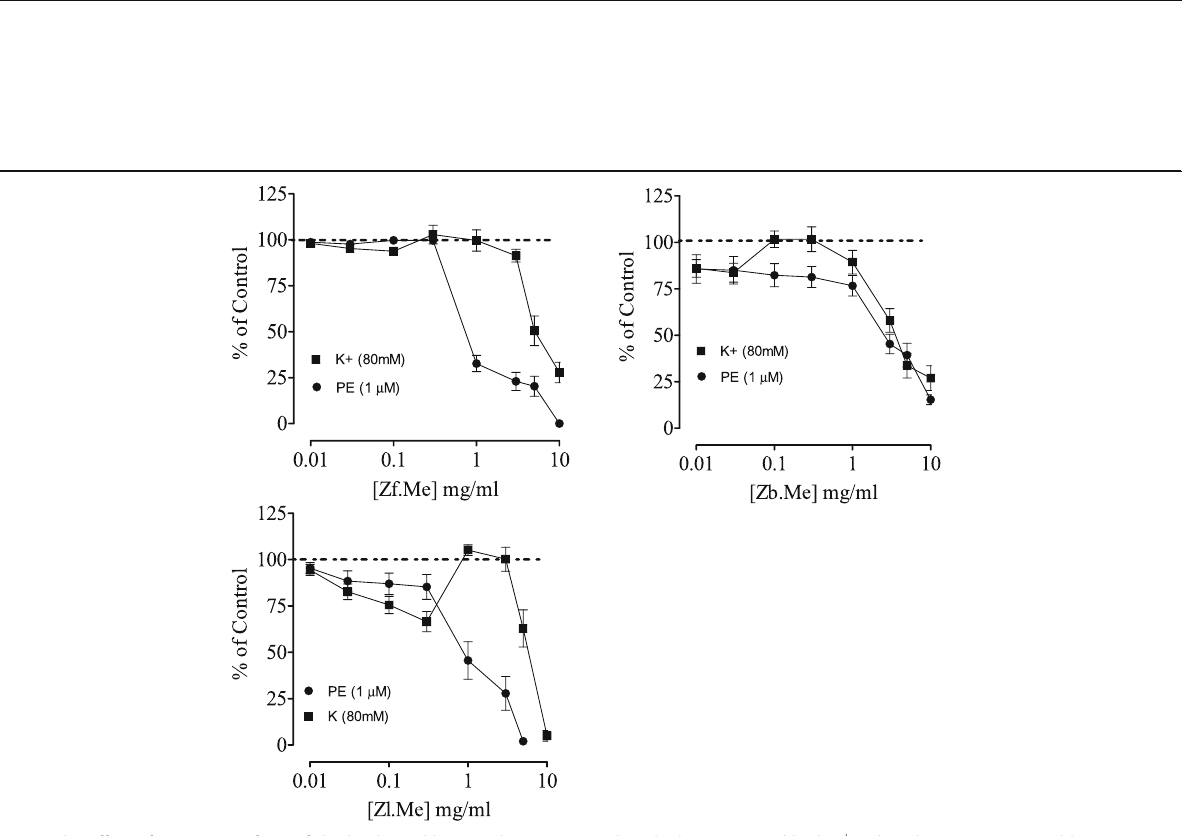
Fig. 3 The effect of Z . armatum fruit (Zf), bark (Zb) and leaves (Zl) extracts on phenylephrine (PE) and high K + induced contractions in rabbit aorta preparation (All values are expressed as the mean±SEM; n